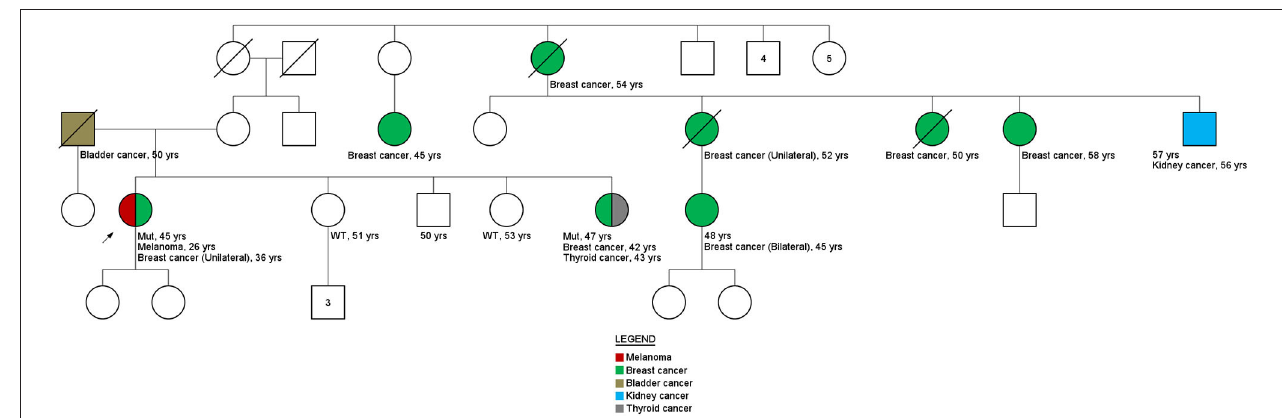
FIGURE 3 | Family history. Pedigree family ID306. Variant c.316C > T in the BRIP1